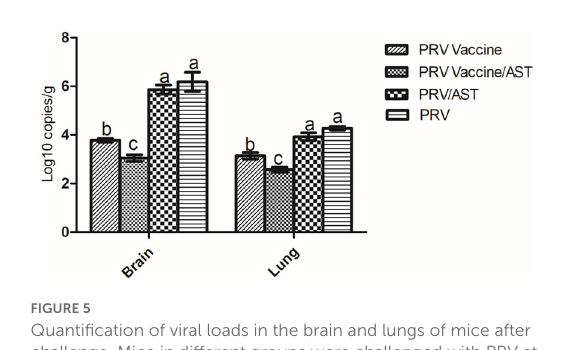
FIGURE5 Quantification of viral loads in the brain and lungs of mice after challenge. Mice in different groups were challenged with PRV at 28 dpi, brain and lung samples were collected from each group at 14 dpc, and the viral loads in the brain and lungs were detected by quantitative real-time PCR. Data are expressed as the mean ± S.D.